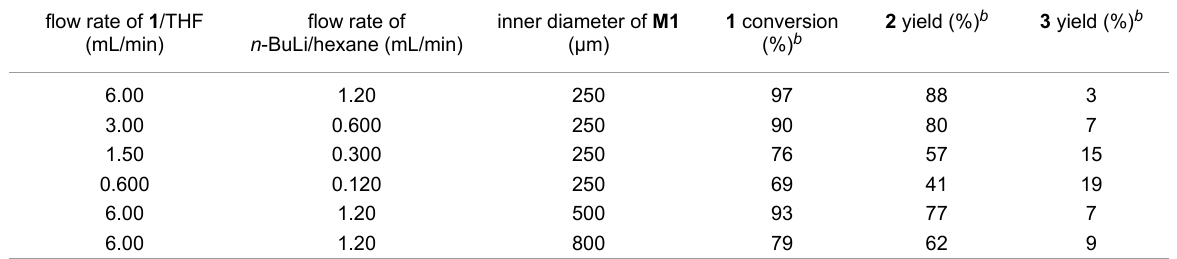
Table 2: Effect of flow rate and inner diameter of M1 at 0 °C. a